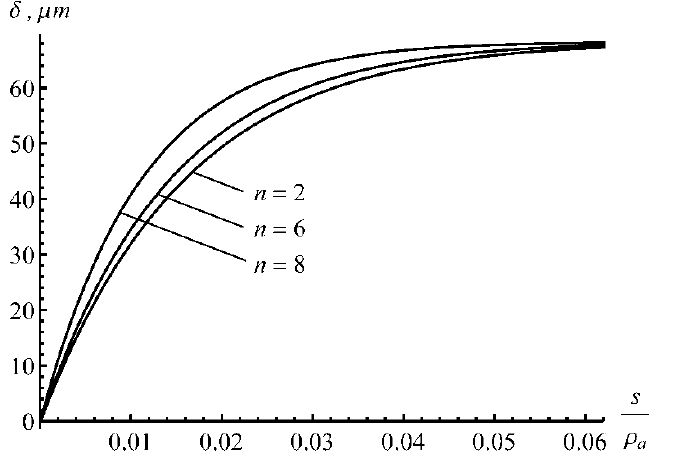
Figure 7. Thickness of the layer of intensive plastic deformation near the entrance to the θ 0 = 30 o die and different n − values.